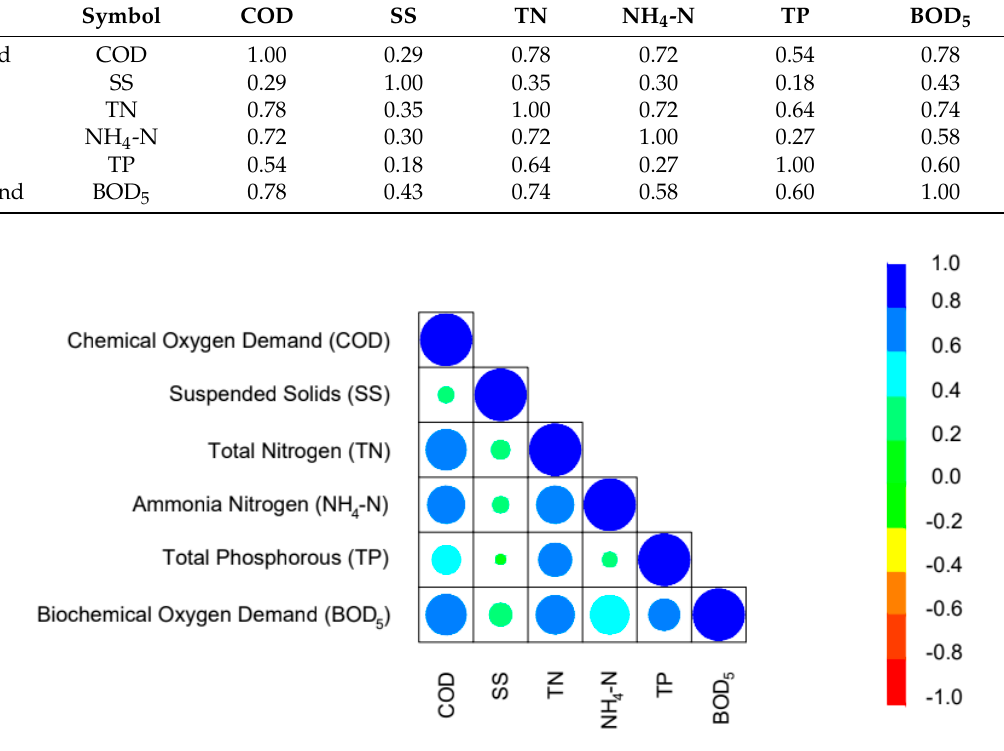
Table 4. Correlation matrix of the studied input and output variables.